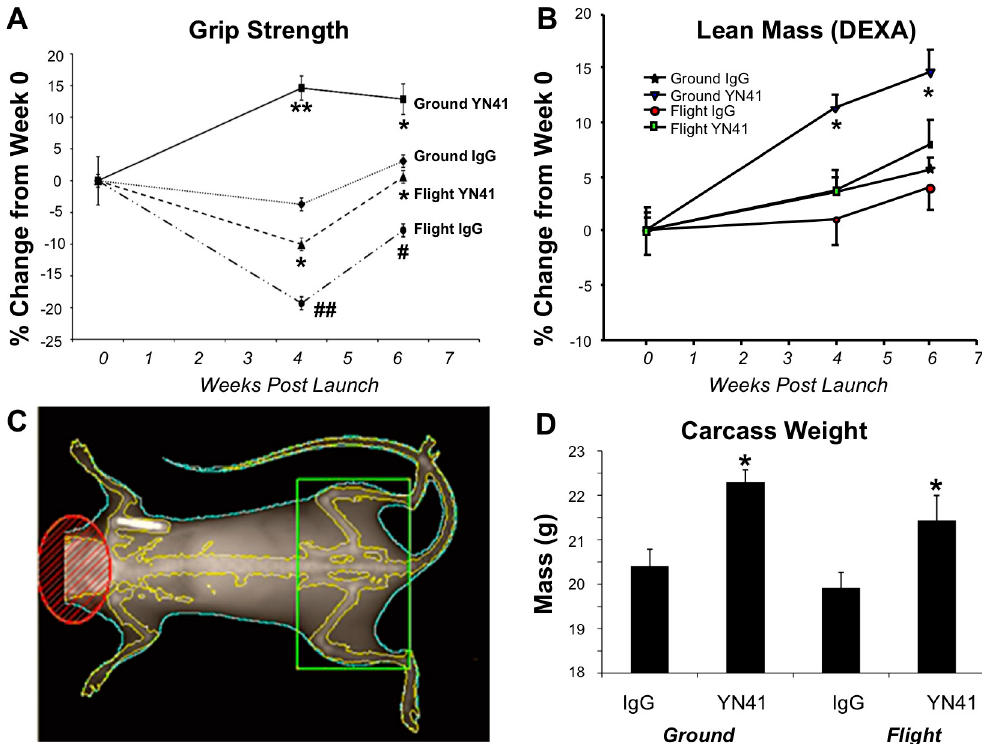
Fig 1. Effect of myostatin inhibition on muscle function and lean muscle mass under conditions of microgravity. Grip strength (A) and lean muscle mass (B) were measured in Ground IgG, Ground YN41, Flight IgG and Flight YN41 groups at launch and weeks 4 and 6 post-launch, expressed as percent change from the same groups measured at baseline, with all baseline measurements having been made on the ground using Lunar PIXImus. (C) Representative mouse image from the DEXA densitometer showing the region of interest (ROI) of the hindlimb outlined in black used in panel B. (D) Carcass weights of all groups. Significance (p < 0.05 � , 0.001 �� ) for comparison to respective control IgG group or to Ground IgG group (p < 0.05 #, p < 0.001 ##) is